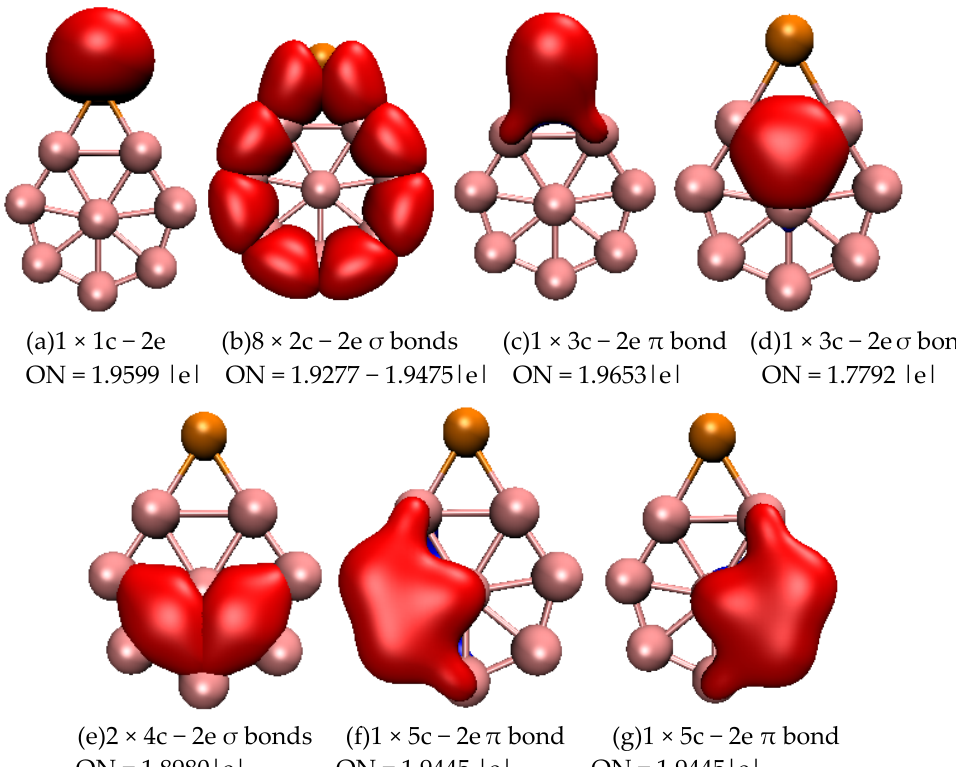
Figure 3. Bonding patterns of SeB 8 . ON is occupation number and the orange ball is Se atom.